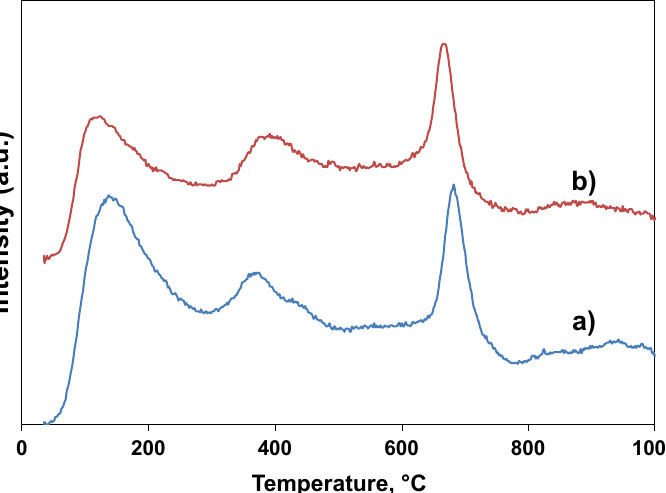
Figure 1. NH 3 temperature programmed desorption (TPD) profiles for: ( a ) CZA; ( b ) 2 Pd-CZA. CZA: Cu/Zn/Al (molar) = 35/35/30. All traces have been displaced for clarity.